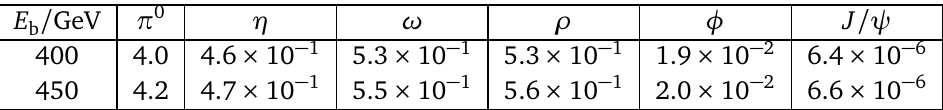
Table 2: The number of mesons produced per proton-proton collision at the relevant energies, using